Question: In one sentence, what is this figure communicating?
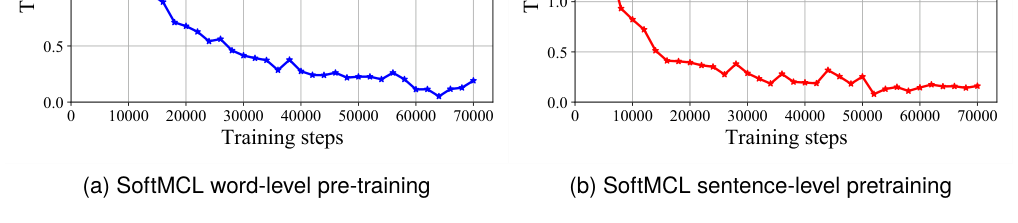
Answer: Training curve of the proposed SoftMCL on word- and sentence-level pretraining.